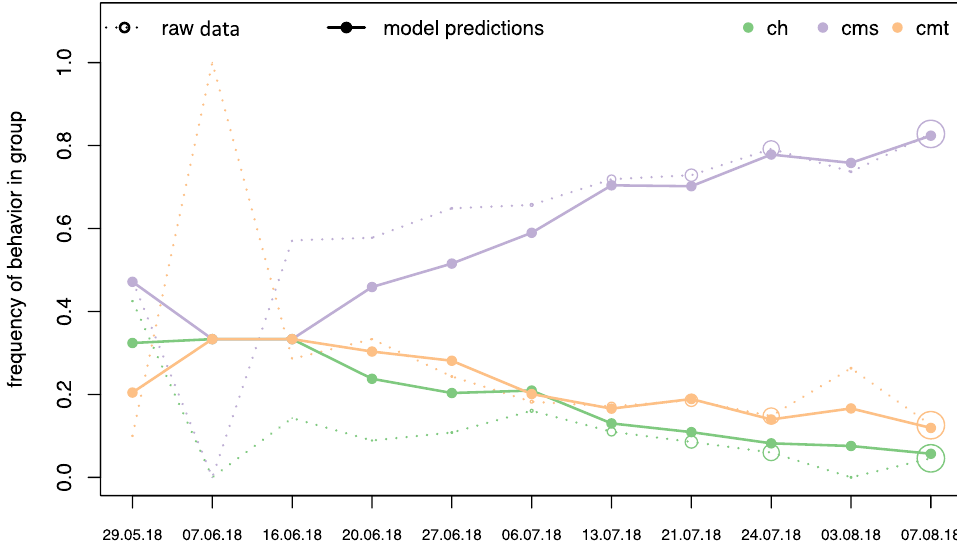
Figure 1. Daily mean group probability of observed processing techniques over experimental days for NH. Filled lines and points are posterior mean predictions of the global model averaged across all individuals in NH in an experimental day. Dashed lines and empty points are estimates from raw data averaged across all individuals in NH in an experimental day. Diameter of empty points of raw data scales with daily sample size.